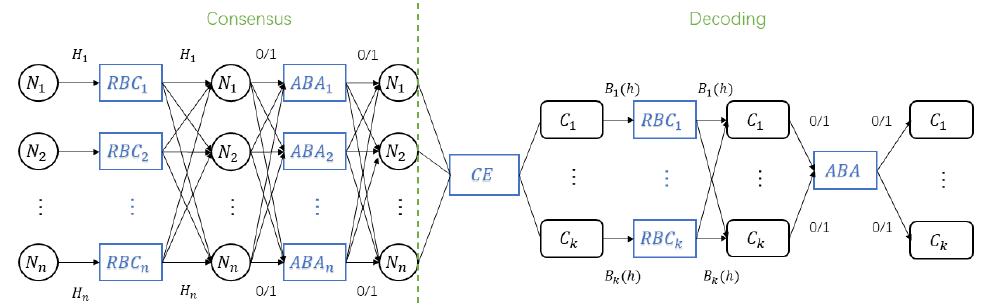
Figure 2. The consensus of encoded values and recovery of blocks flows in